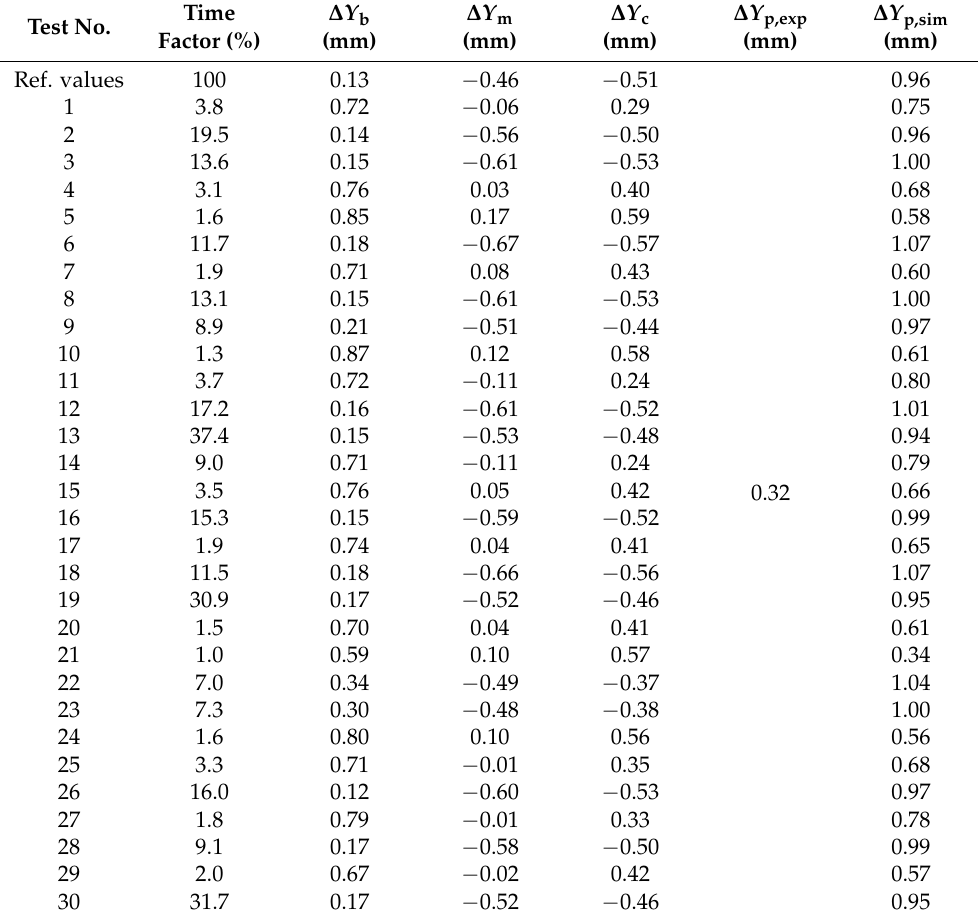
Table 3. Training and validation measures obtained for Y m dependent variable.